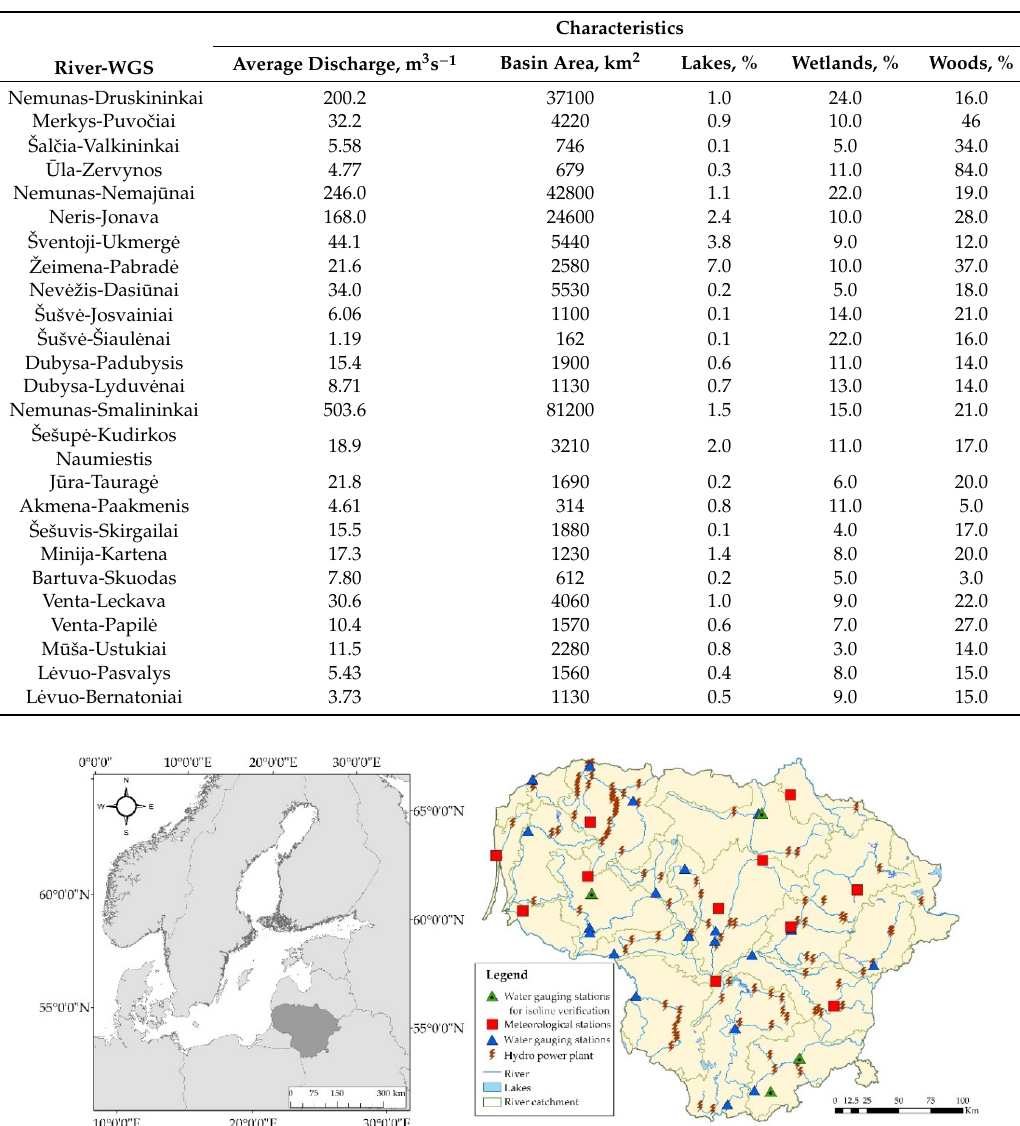
Table 1. Main characteristics of the studied gauging station catchments [19].